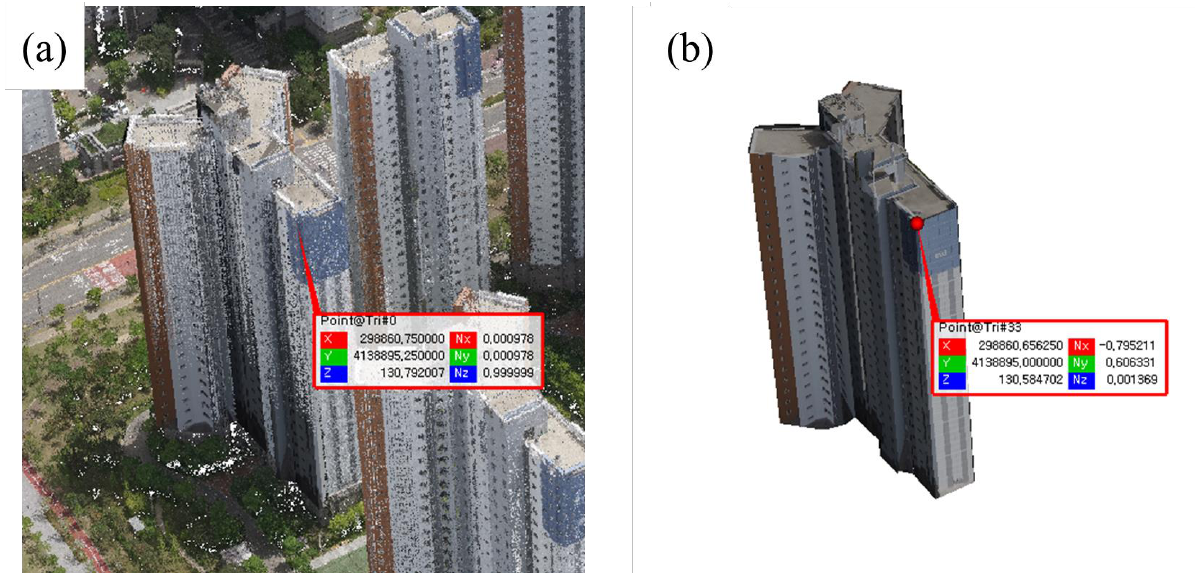
Figure 15. Accuracy Measurement. (a) Point cloud, (b) Model